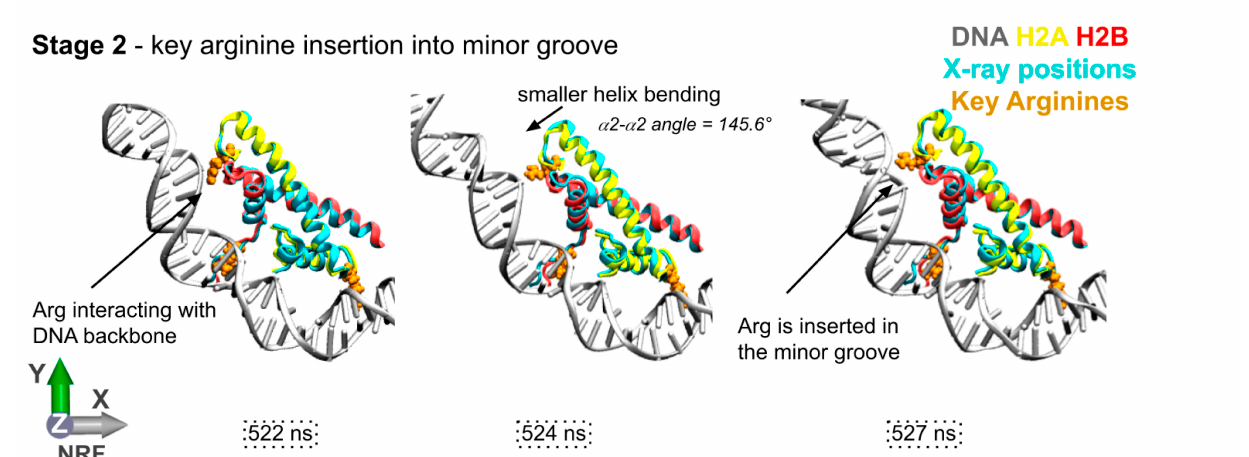
Figure 4. Interplay between H2A-H2B dimer bending, DNA twist-defects and wrap- ping/unwrapping dynamics. ( a ) α 2- α 2 angle distributions for different simulated NCP systems. ( b , c ) Snapshots illustrating DNA geometry and H2A-H2B bending upon twist-defect relaxation in the NCP tt 145 system. ( d ) MD snapshots illustrating the DNA rewrapping process and the H2A-H2B bending during this